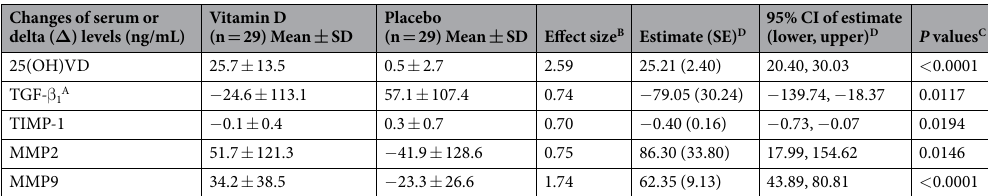
Vitamin D (n = 29) Mean ± SD